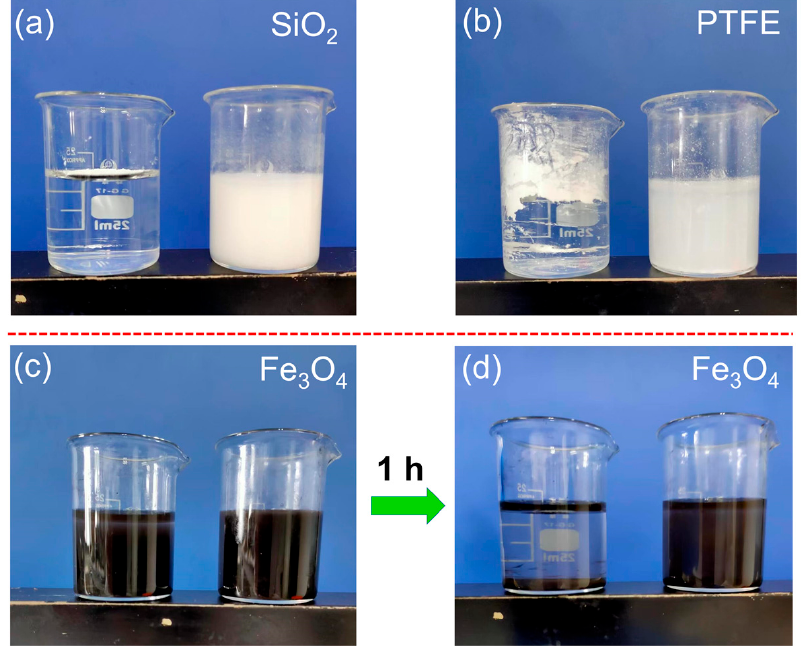
Figure 3. Comparison of the suspension effect for HPs and PEI-modified HPs. ( a ) Hydrophobic SiO 2 particles ( left ) and PEI@SiO 2 HPs ( right ) directly dispersed in water; ( b ) PTFE HPs ( left ) and PEI@PTFE HPs ( right ) dispersed in water. ( c ) Images of freshly prepared Fe 3 O 4 particles ( left ) and PEI@Fe 3 O 4 particles ( right ) dispersed in water. ( d ) Images of Fe 3 O 4 particles ( left ) and PEI@Fe 3 O 4 particles dispersed in water and settled for 1 h.